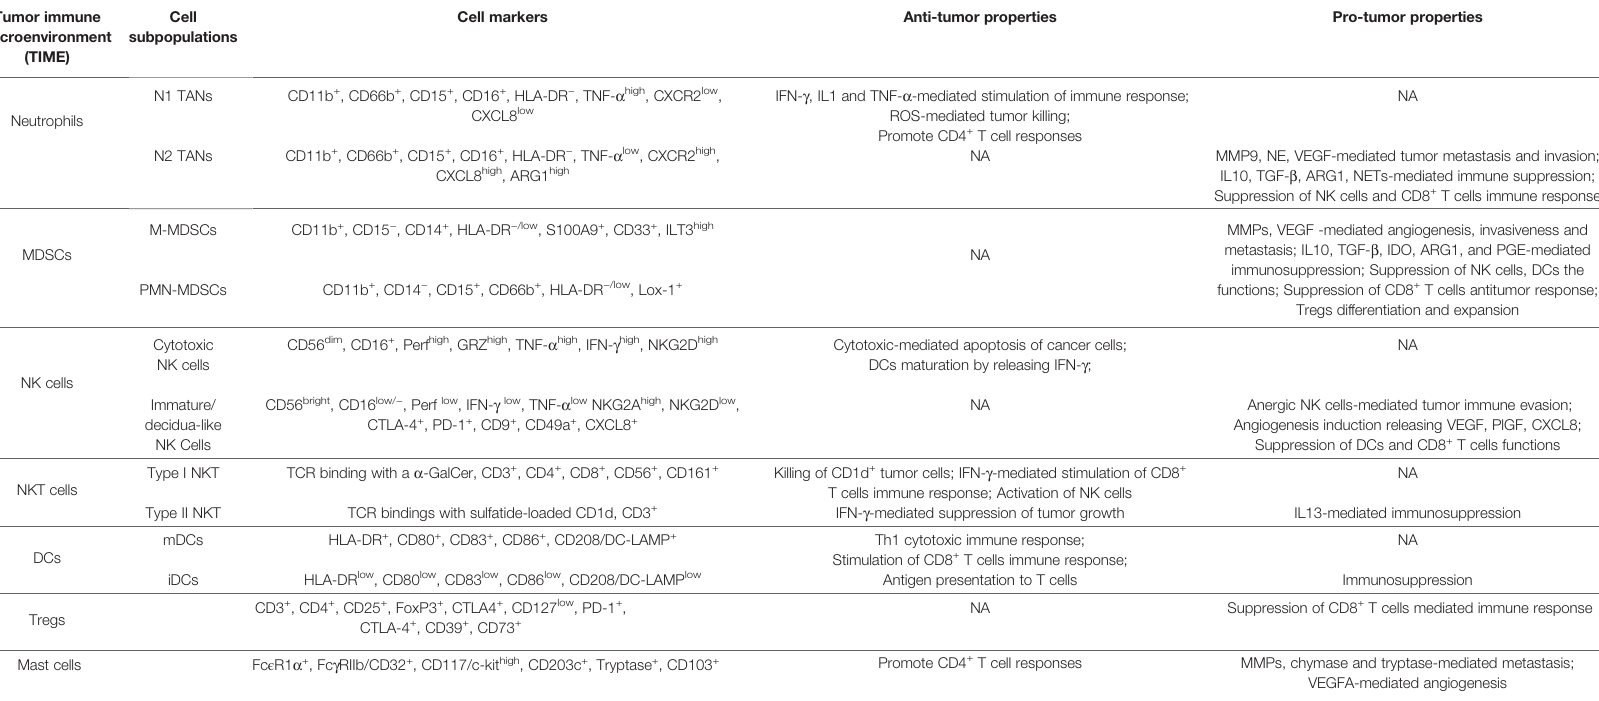
TABLE 1 | NSCLC immune landscape: anti- and pro-tumorigenic phenotypes and activities of immune cell populations within the tumor